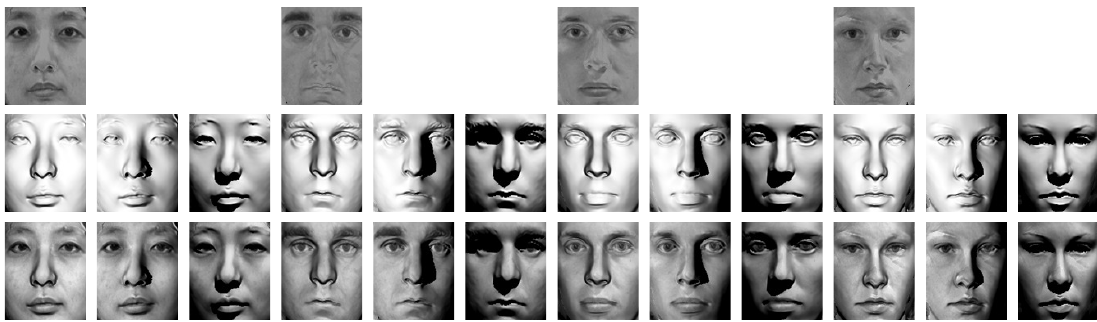
Figure 1. Examples of reflectance and illuminance of face images (synthesized from the FRGC 2.0 database [51]): ( Top ) Reflectance (or albedo); ( middle ) illuminance; and ( bottom ) corresponding